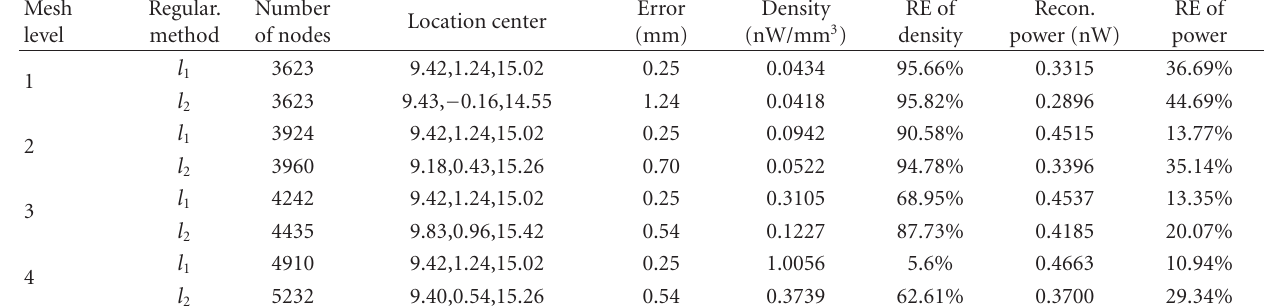
Table 1: Reconstruction results in single source case on di ff erent mesh levels.